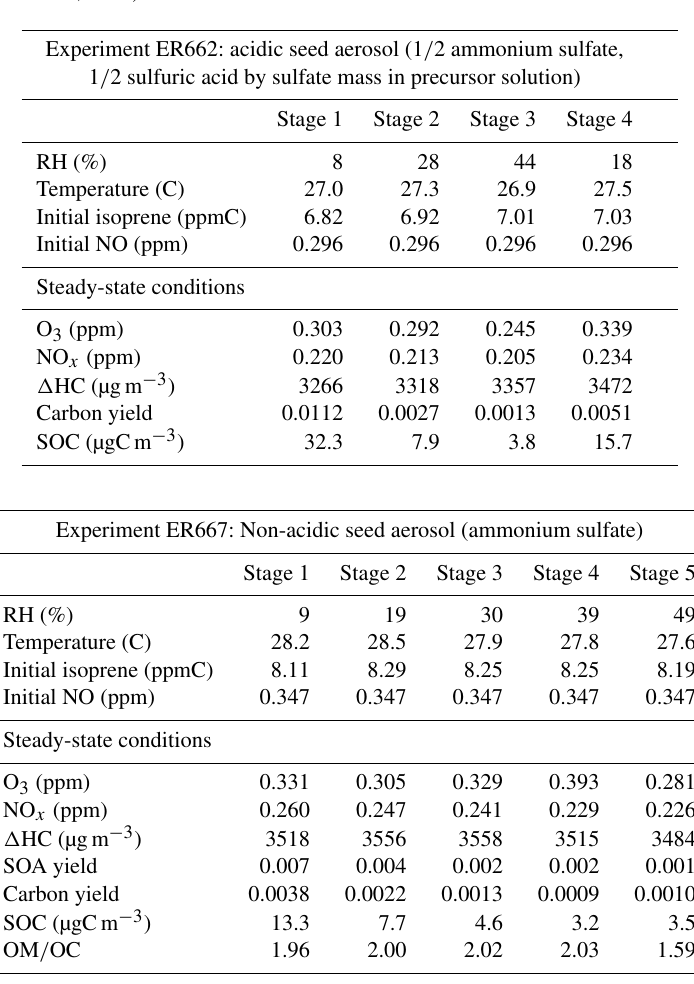
Table 1. Initial and steady-state conditions, yields, and OM / OC data for chamber experiments on isoprene photooxidation in the presence of acidic and non-acidic seed aerosol. The initial NO x was entirely nitric oxide. The non-acidic experiment was conducted with a low- concentration ammonium sulfate seed ( ∼ 1µgm − 3 ) . The acidic experiment was conducted with a higher concentration of inorganic seed ( ∼ 30µgm − 3 ) generated from a nebulized solution for which half the sulfate mass was derived from sulfuric acid and the other half from ammonium sulfate (Lewandowski et al.,